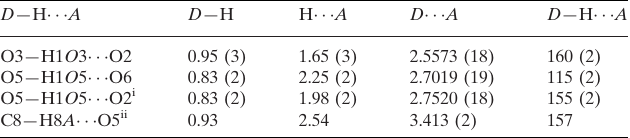
Hydrogen-bond geometry (A˚ , (cid:4)